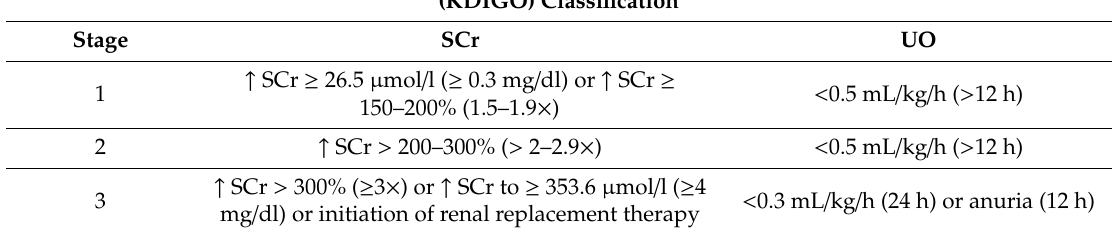
Table 1. Acute kidney injury according to the Kidney Disease: Improving Global Outcomes (KDIGO) classification. SCr—serum creatinine, UO—urinary